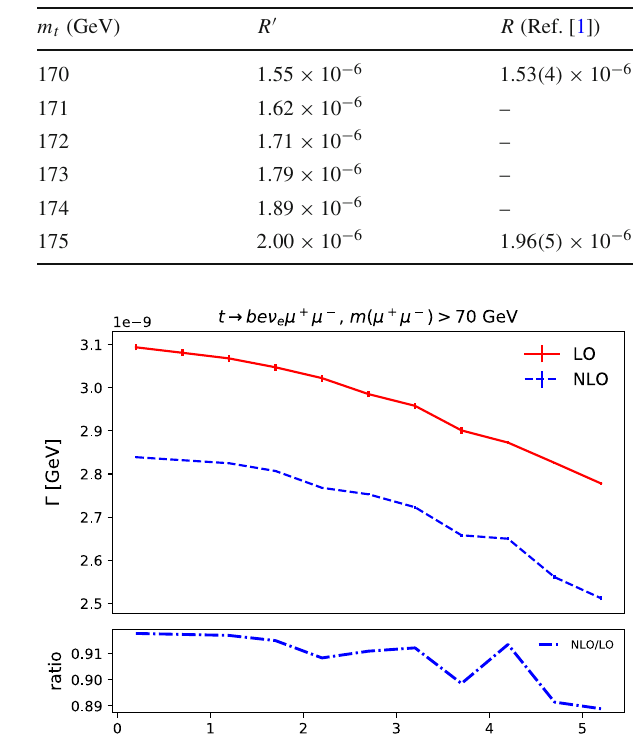
Table 1 The ratio of branching ratios defines the t → bW Z as described in the main text. The results of Ref. [1] are only provided in 5 GeV intervals